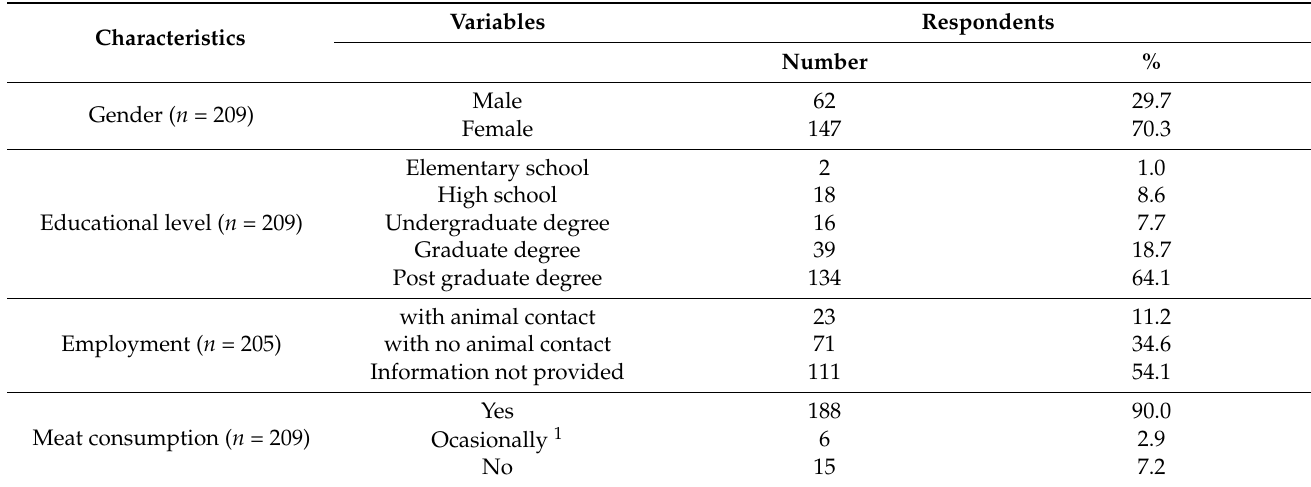
Table 3. A description of lay citizen respondents from Porto Alegre, Brazil, in the survey regarding animal welfare and animal maltreatment, from September 2017 to December